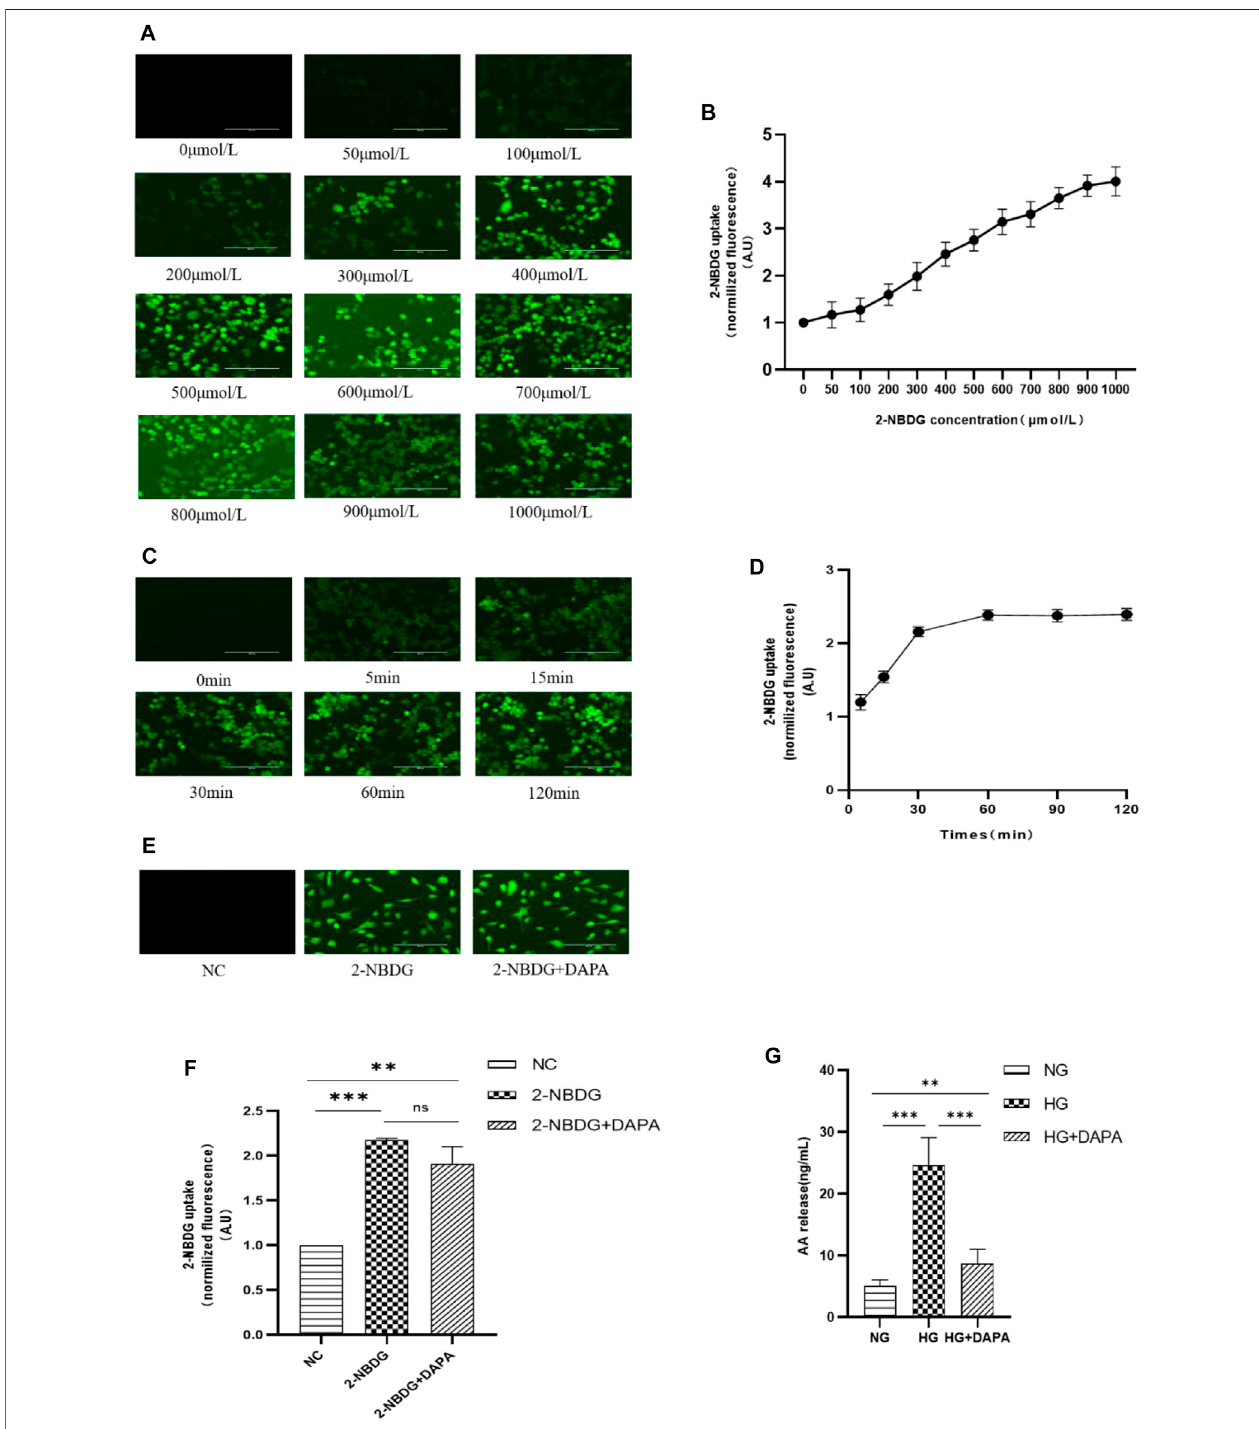
FIGURE 5 | Effect of DAPA on glucose uptake and arachidonic acid (AA). (A,B) The concentration of 2-NBDG acting on HRMECs. (C,D) The time of 2-NBDG acting on HRMECs. (E,F) The effect of DAPA on glucose uptake ofHRMECs. (G) The effect of DAPA on AA of HRMECs. Data are presented as means ± SD. * p < 0.05, ** p < 0.01, *** p < 0.001.